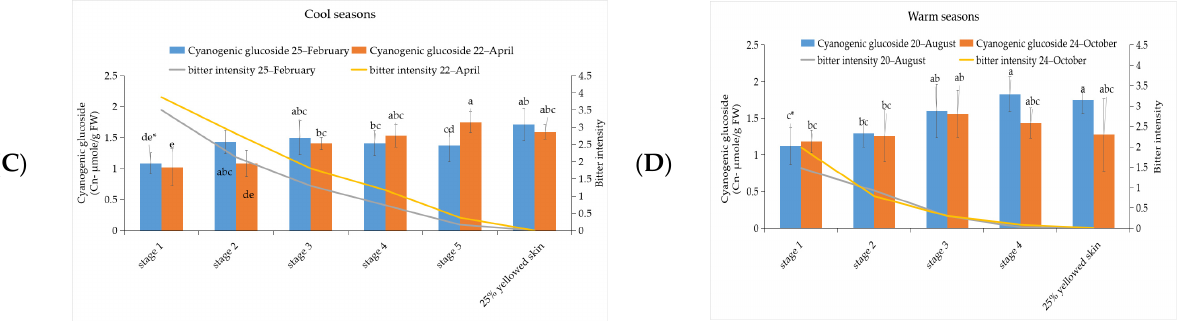
Figure 2. The correlation of phenylalanine content ( A , B ) and cyanogenic glucoside content ( C , D ) with bitterness intensity in different maturity stages of papaya fruit during cool season and warm season. Data are mean ± SD, n = 4. * Mean statistical data within a column were obtained by Duncan’s test at the 5% level (same letters means no significance).